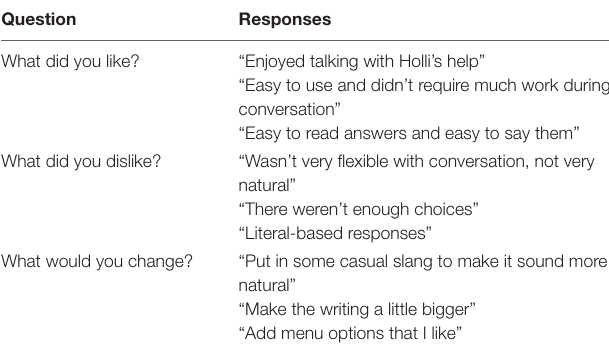
Table 3 | Semi-structured interview representative responses.